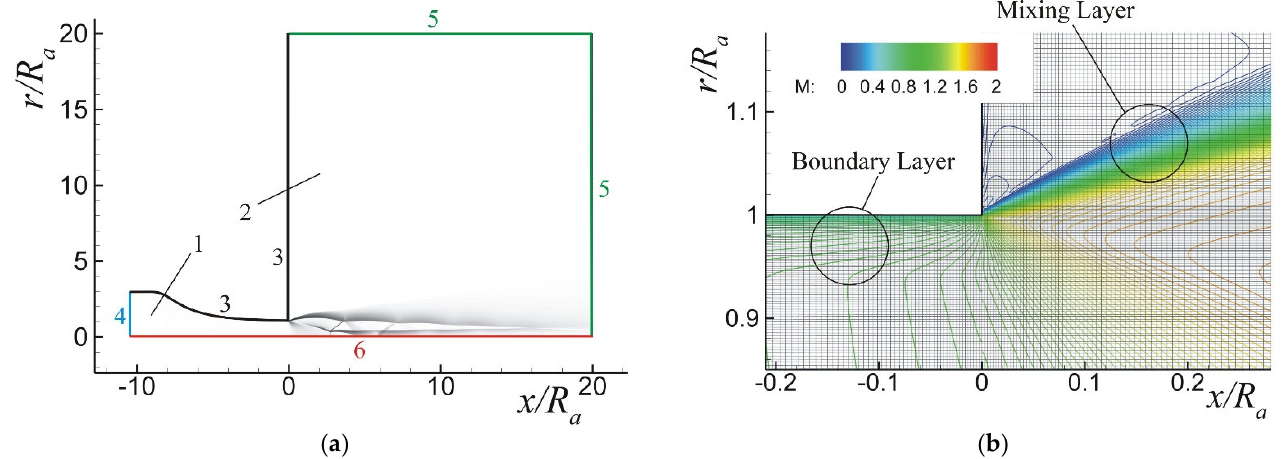
Figure 4. Computational domain ( a ): 1—nozzle, 2—ambient space, 3—wall, 4—inlet boundary, 5—outlet boundary, 6—axis of symmetry; ( b ) fragment of the grid near the nozzle exit. The boundary conditions on the walls of the computational domain (Figure 4a), Spatial discretization of the conservation and transport equations was performed denoted by the number 3: the gas velocity is zero; there is no heat transfer between the using a first-order upwind scheme. Flux values were calculated using the Roe-FDS (flux- nozzle surface and the gas. The calculation of the boundary layer inside the nozzle is difference splitting) scheme [22]. Flow parameter gradients were calculated using the Green–Gauss cell-based method